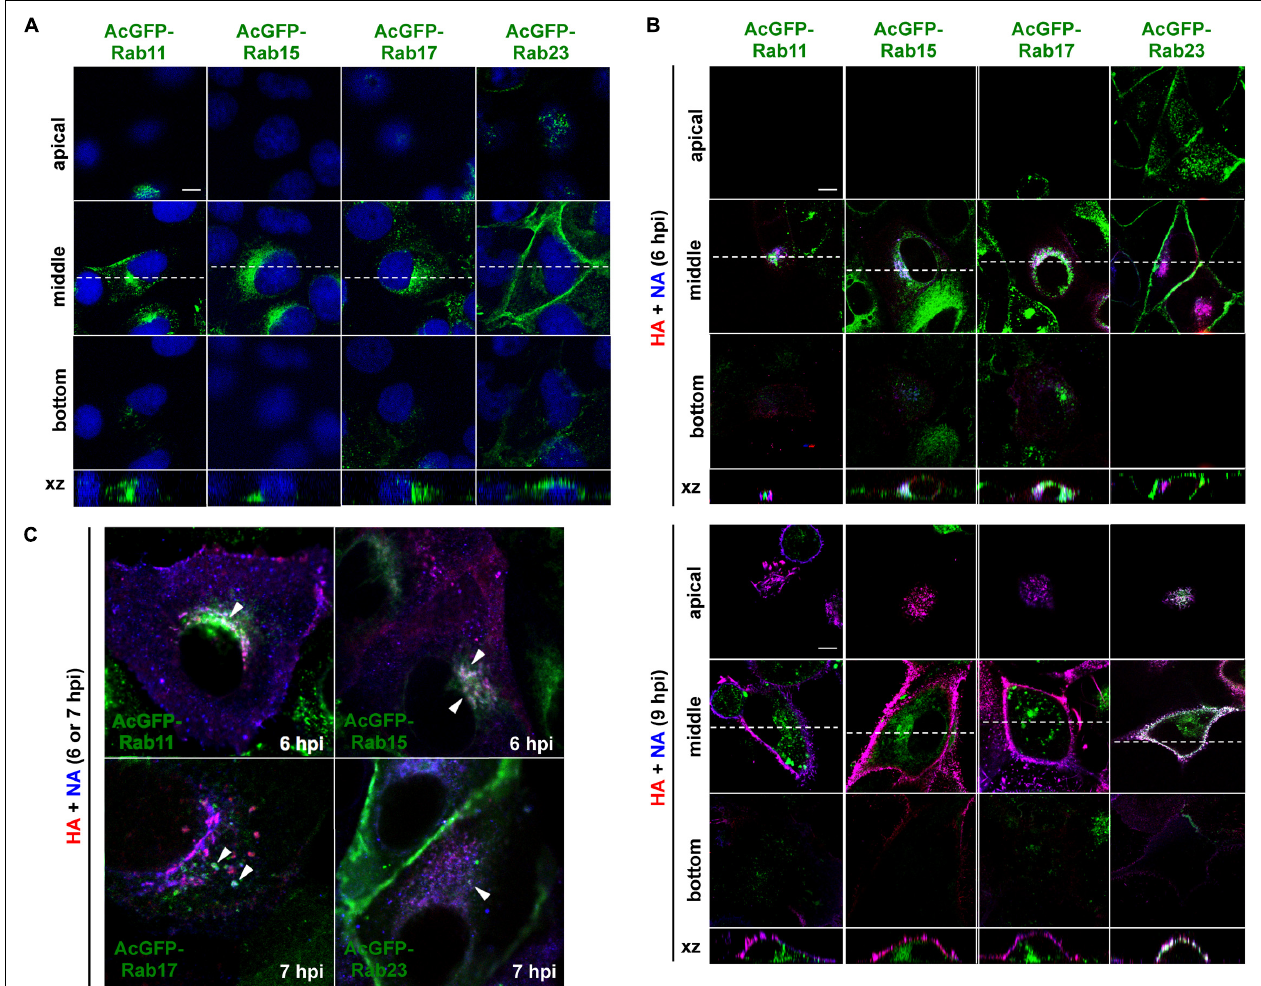
FIGURE 3 | Localization of HA and NA in MDCK cells stably expressing AcGFP-Rab proteins. (A) MDCK cells stably expressing AcGFP-Rab proteins. MDCK cells were transfected with AcGFP-Rab11, Rab15, Rab17, and Rab23 expression plasmids and MDCK cells stably expressing AcGFP-Rab were established by single cell cloning. Cell nuclei were stained with DAPI (blue). (B) Localization of HA and NA. MDCK cells stably expressing AcGFP-Rab were infected with influenza A virus. At 6 and 9 hpi, the cells were stained with anti-HA mAb (red), anti-NA Ab (blue). Confocal images in the xy planes at the apical, middle, and bottom positions, and reconstituted images in the xz planes were shown. Dashed lines in xy images indicate the positions of xz images. All images were taken at the same magnification. Scale bar, 10 µ m. (C) Enlargement of confocal xy images. Arrowheads indicate colocalization of HA, NA, and